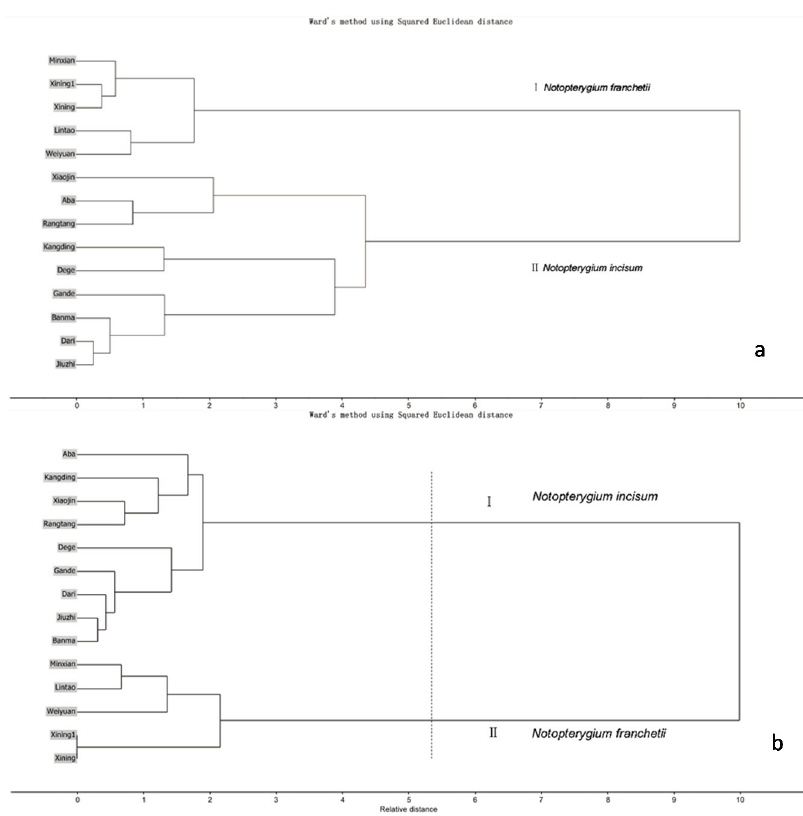
Figure 2. Hierarchical cluster analysis (HCA) results of 14 batches of Qianghuo samples based on GC-MS chromatograms ( a ) and HPLC fingerprints ( b ), respectively.